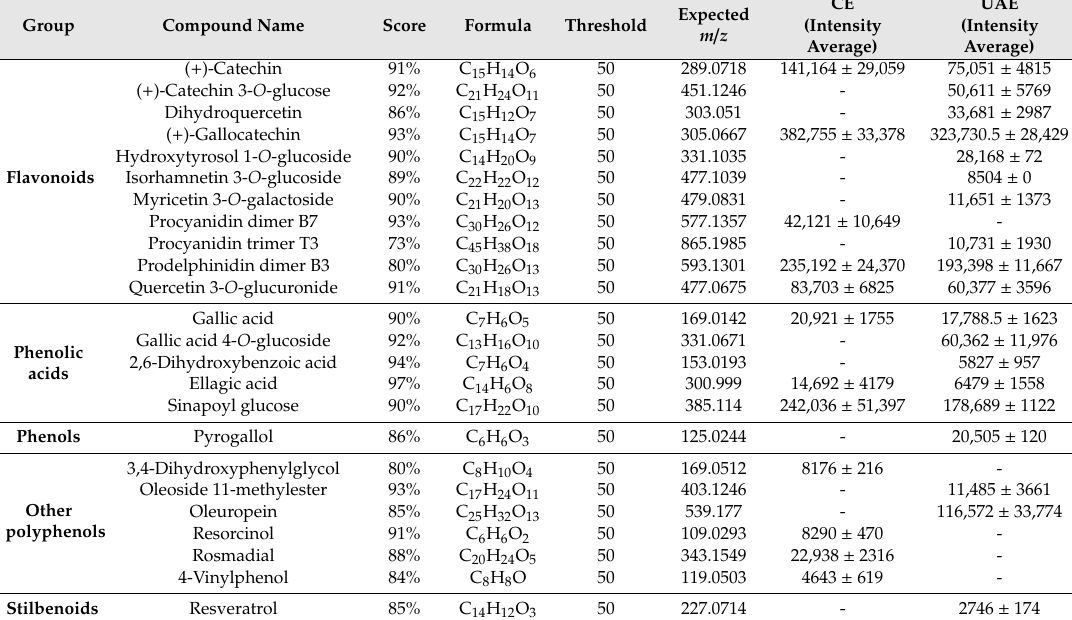
Table 1. Specific polyphenols (peak intensity) identified in Erodium glaucophyllum aqueous extracts confirmed by TOF–LC–MS–MS obtained by conventional extraction (CE) and ultrasound-assisted extraction